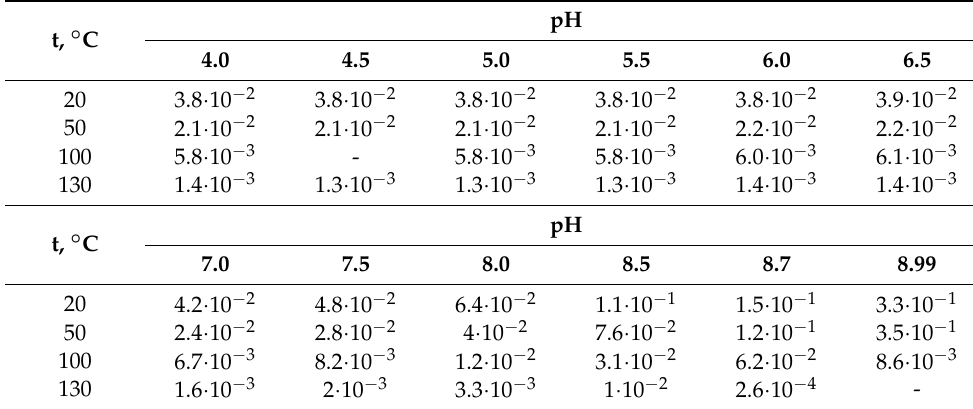
Table 4. Dependence of Zeldovich factor Z on the temperature and pH (-).